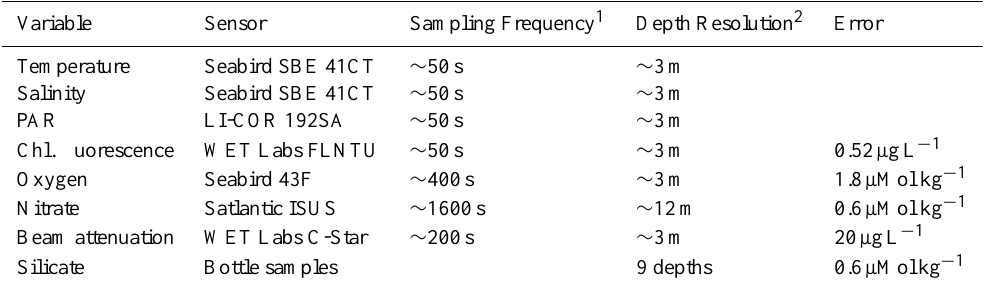
Table 1. Data used in modeling. All data are from the Lagrangian float except for silicate, which is from bottle samples. Each day the float profiled to about 250m. For the rest of the day, it sampled continuously within the mixed layer. Estimated errors in a single 1-m by 1-day bin are shown for variables used in the optimization.